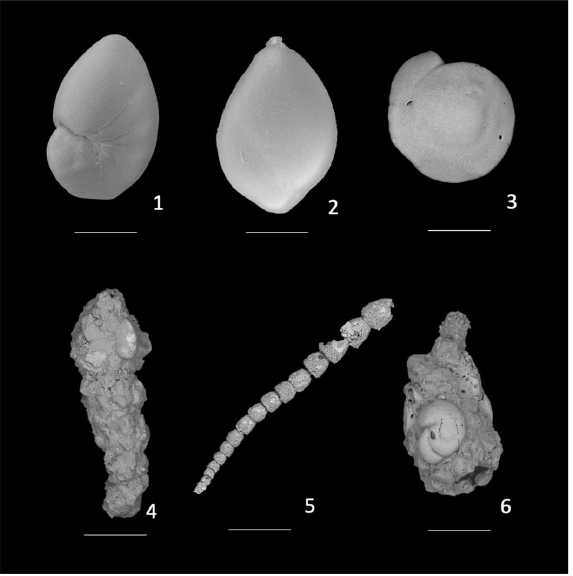
Figure 4. Scanning Electronic Microscopy (SEM) images of some of the main hard-shelled foraminiferal species. Calcareous species: 1. Nonionellina labradorica ; 2. Globobulimina auriculata ; 3. Alabaminella weddellensis ; Agglutinated species: 4. Reophax scorpiurus ; 5. Leptohalysis scottii ; 6. Lagenammina difflugiformis . Scale bar 50 µm. Species richness (S) of the entire live benthic assemblages varied along the transect inside the Kveithola Trough from the minor drift to the grounding-zone wedge (Table 2).